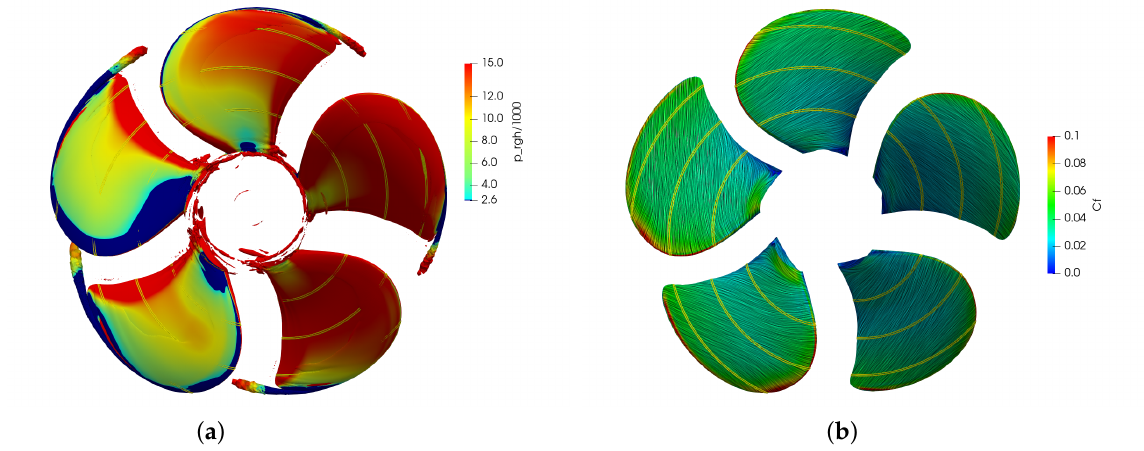
Figure 16. PPTC VP1304 mounted on 12 ◦ inclined shaft, J = 1.019, non-cavitating condition predictions using k − ω SST model. ( a ) Q = 3 × 10 5 colored by pressure; ( b ) wall limiting streamlines and contours of C f